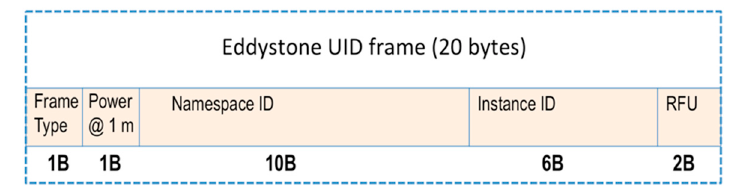
Figure 11. Eddystone advertising frame format (UID).